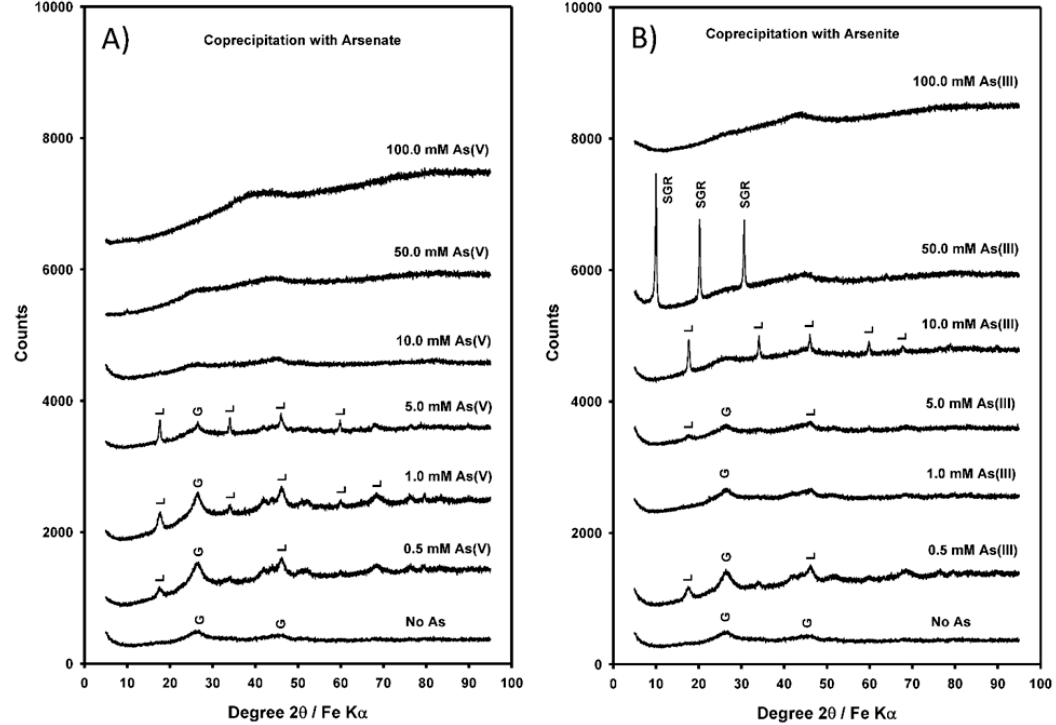
Figure 1. ( A ): X-ray di ff ractogram of coprecipitate minerals formed at varying dissolved arsenate concentrations of 0, 0.5, 1.0, 5.0, 10.0, 50.0, and 100 mM (L = lepidocrocite, G = goethite); ( B ) X-ray di ff ractogram of coprecipitate minerals formed at varying dissolved arsenite concentrations of 0, 0.5, 1.0, 5.0, 10.0, 50.0, and 100 mM (SGR = sulfate green rust, L = lepidocrocite, G =